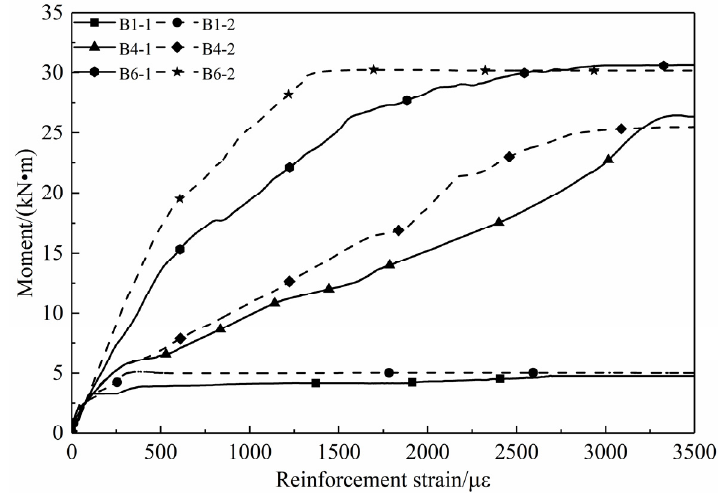
Figure 6. Moment–reinforcement strain curves for the RASCC and NC beams.